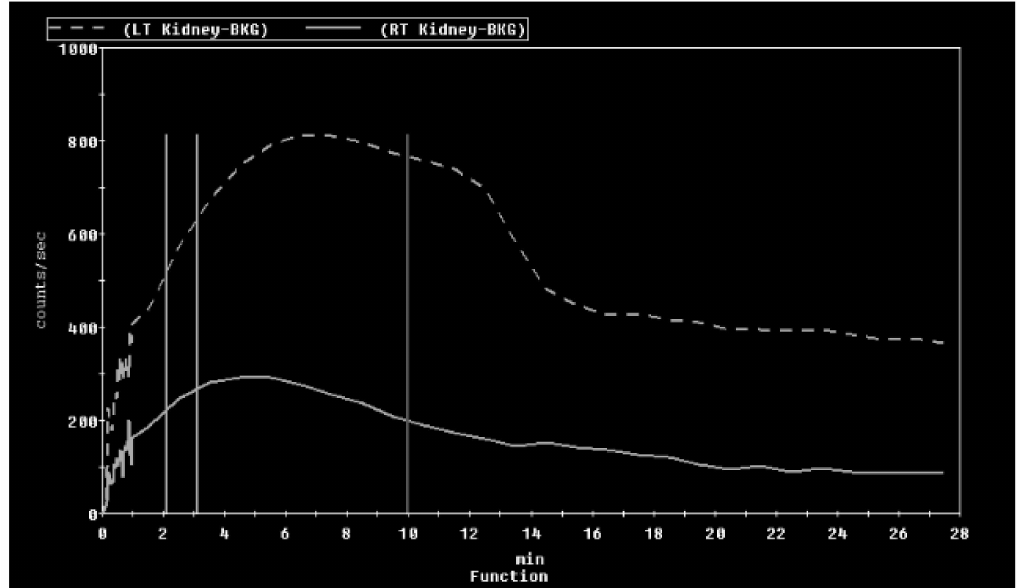
Figure 2. MAG-3 diuretic renal scan showing the time–activity curves in the drainage phase. MAG-3 was promptly excreted from the left kidney, which was augmented by furosemide. MAG-3 was progressively drained from the right kidney with no acceleration with furosemide. The x-axis is labelled as radiotracer activity in counts / sec, and the y-axis is labelled as time in minutes following the infusion of the